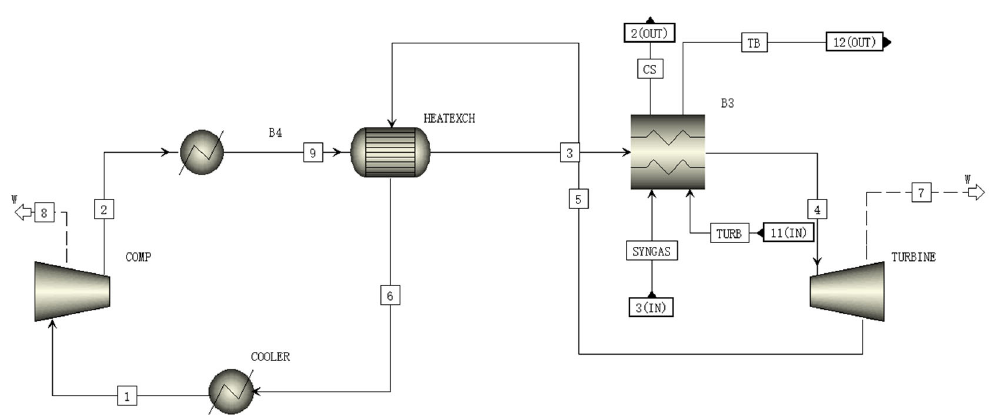
Figure 7. A schematic of the BRAYT module flowsheet. The temperatures of CO 2 in streams 2, 3, 5 and 6 in Figure 6 are 71.5 ◦ C, 338.4 ◦ C, 436.1 ◦ C and 81.0 ◦ C, which are close to the reported data of 65.9 ◦ C, 323.9 ◦ C, 434.7 ◦ C and 75.4 ◦ C, respectively [35]. Table 9 shows the materials and parameters of all streams in BRAYT